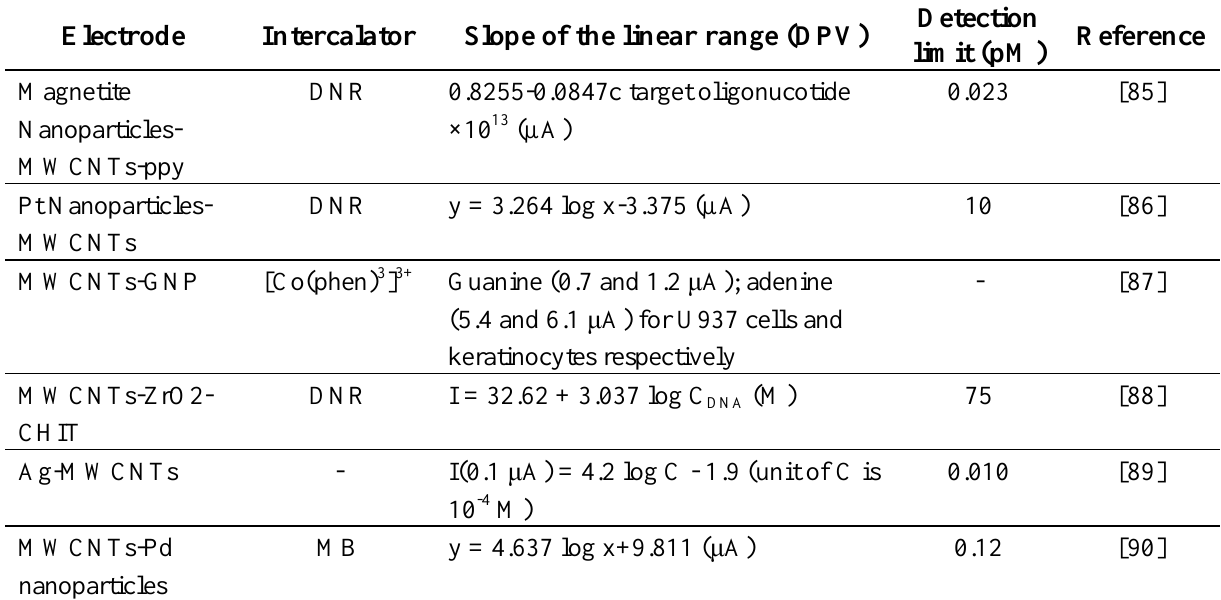
Table 2. Summary of sensitivity values and detection limits of various